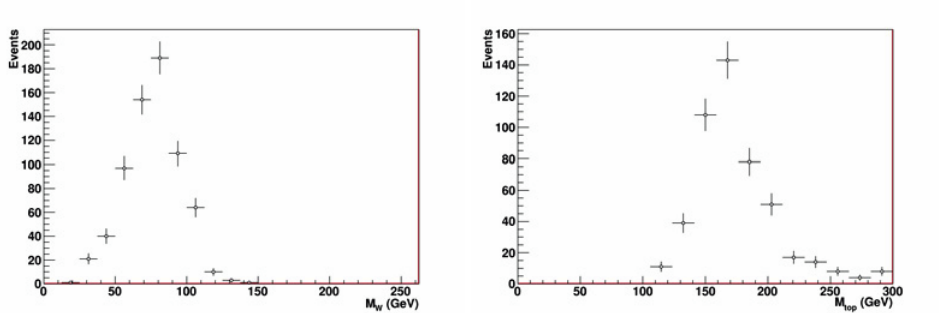
Figure 5. Reconstructed m W when requiring m t to be in the range 150-190 GeV (left) as well as reconstructed m t when requiring m W to be in the range 70-90 GeV (right), for a sample of signal and background events corresponding to an intergrated luminosity of 1 fb − 1